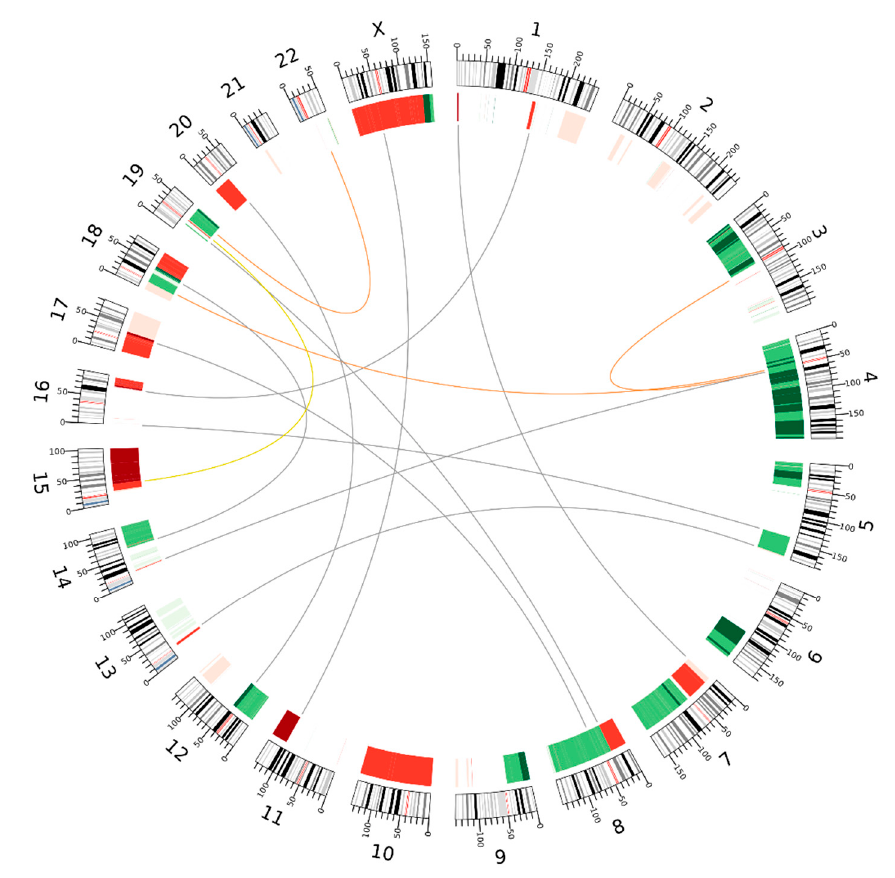
Figure 4. Circos plot of chromosomal translocations and DNA copy number differences in HaCaT and HaCaT/SM. Copy number differences between HaCaT/SM and HaCaT are plotted next to the radially oriented chromosome ideograms. Green indicates higher and red indicates lower DNA copy number in HaCaT/SM relative to HaCaT. The degree of copy number change as defined by their array CGH log 2 ratio is indicated by three different grades of color saturation to enable the distinction of moderate from high copy number changes (dark color: log 2 threshold ± 0.5, medium color: log 2 threshold 0.2, and light color: log 2 threshold 0.12; see Section 4 for details). Orange links within the ideogram show translocations common to both cell lines, whereas yellow and gray links show those specific to HaCaT and HaCaT/SM, respectively. Coordinates of translocation breakpoints are provided in Supplementary Table S2. Visualization was done by means of Circos [46].